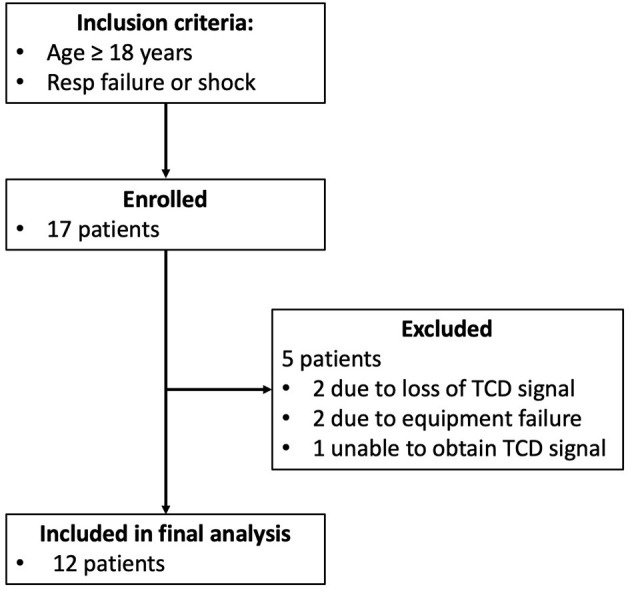
Patient enrollment flow diagram.